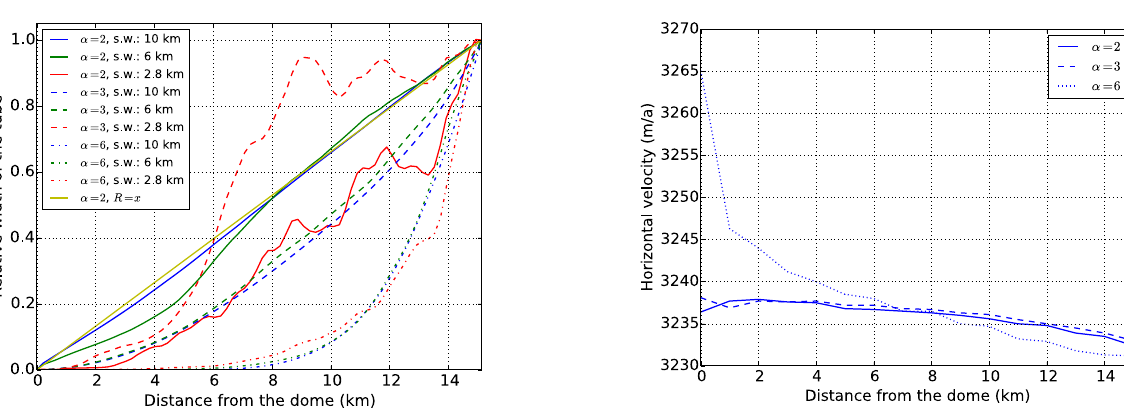
Figure 5. Relative width of the flow tube W for the different dome geometries: circular ( α = 2, solid lines), slightly elongated ( α = 3, dashed lines) and very elongated ( α = 6, dotted lines); for differ- ent scanning windows: 2.8km (red), 6km (green) and 10km (blue). The yellow curve is the line for which R = x is imposed (axisym- metric case).